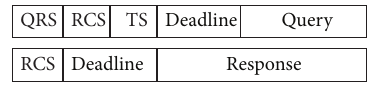
Figure 1: Assumed WSN model.